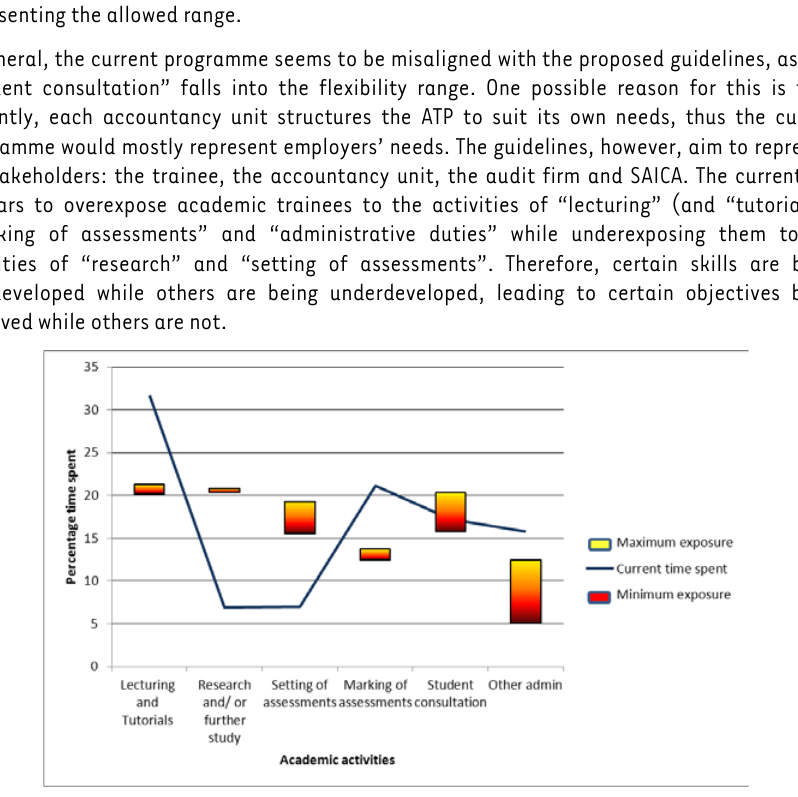
FIGURE 1: Plotting the current ATP structure to the proposed guidelines Source: Authors’